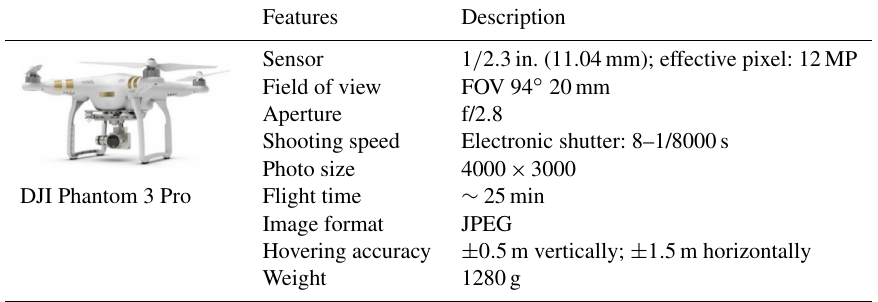
Table A2. Features of the DJI Phantom 3 Pro.